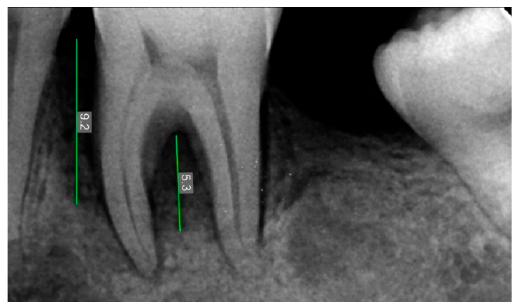
Figure 1. Study protocol.